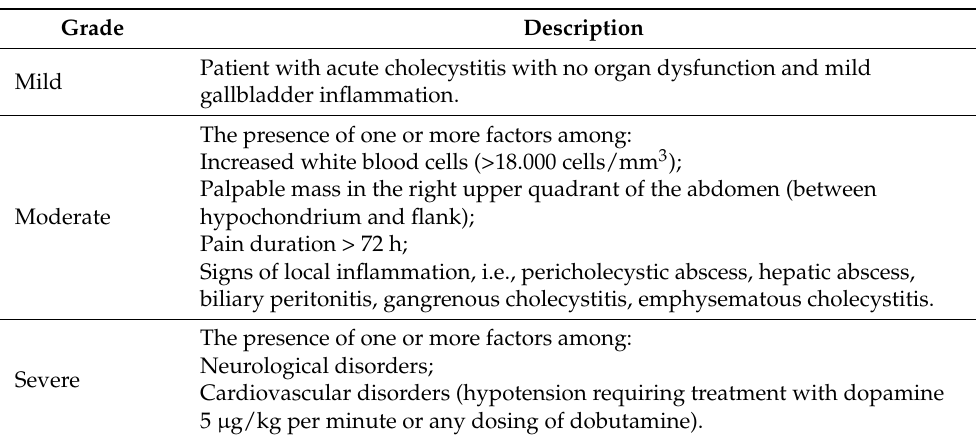
Table 1. Tokyo Guidelines indicating the severity of acute